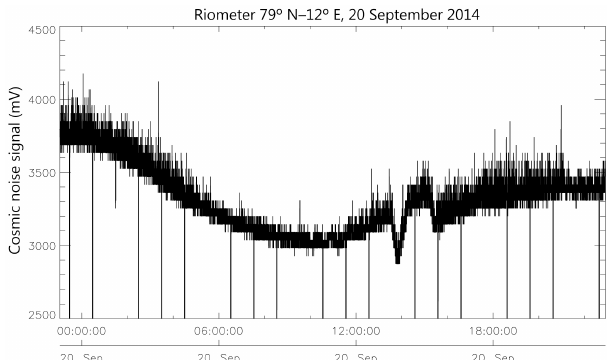
Figure 2. Detail plot of cosmic noise at 40MHz measured by ri- ometer at Ny-Ålesund, 79 ◦ N, 12 ◦ E for 20 September 2014. Origi- nal samples are shown, including the hourly calibration